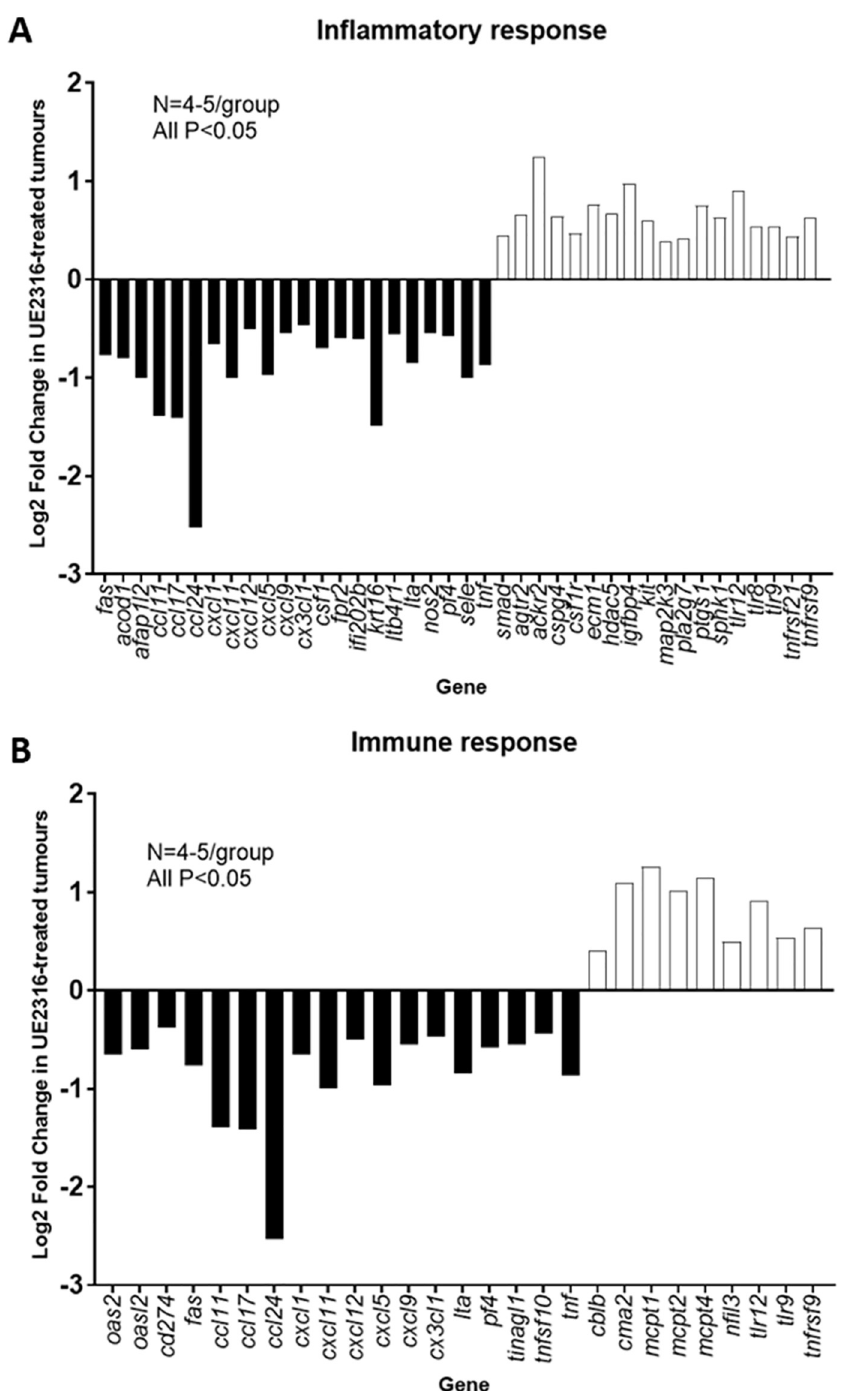
Fig 7. UE2316 affects inflammatory and immune response genes in SCC tumours; analysed using Gene Ontology analysis. Differentially-expressed genes identified by RNA-sequencing were defined as being related to the inflammatory response (A) or immune response (B) by Gene Ontology analysis. N = 4-5/group. A modified Fisher Exact test was used to determine whether the proportion of genes in a given list was significantly associated with a biological process compared to the murine genome: P < 0.05 for all the above. Data represent mean values with black bars representing genes that are down-regulated in the UE2316-treated tumours and open bars those that are up-